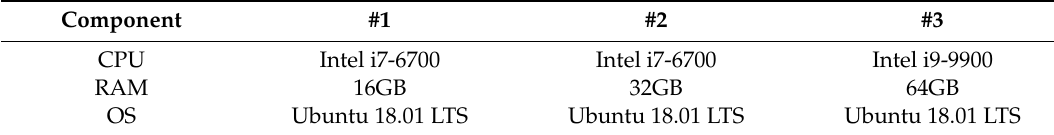
Table 4. Experiment